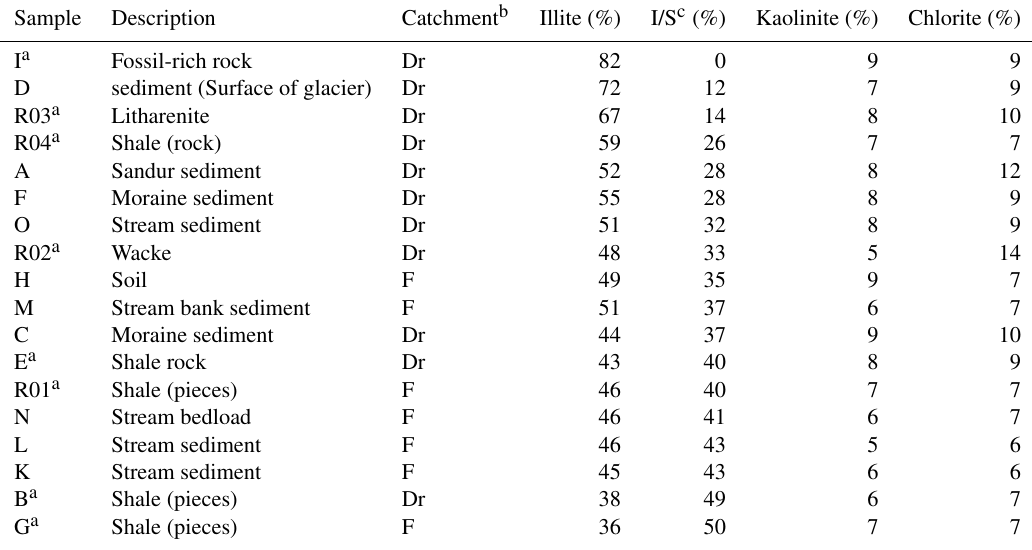
Table 2. Relative proportions of clay minerals as determined from XRD patterns for the solid samples collected in the two catchments. Samples are ordered from highest to lowest relative illite